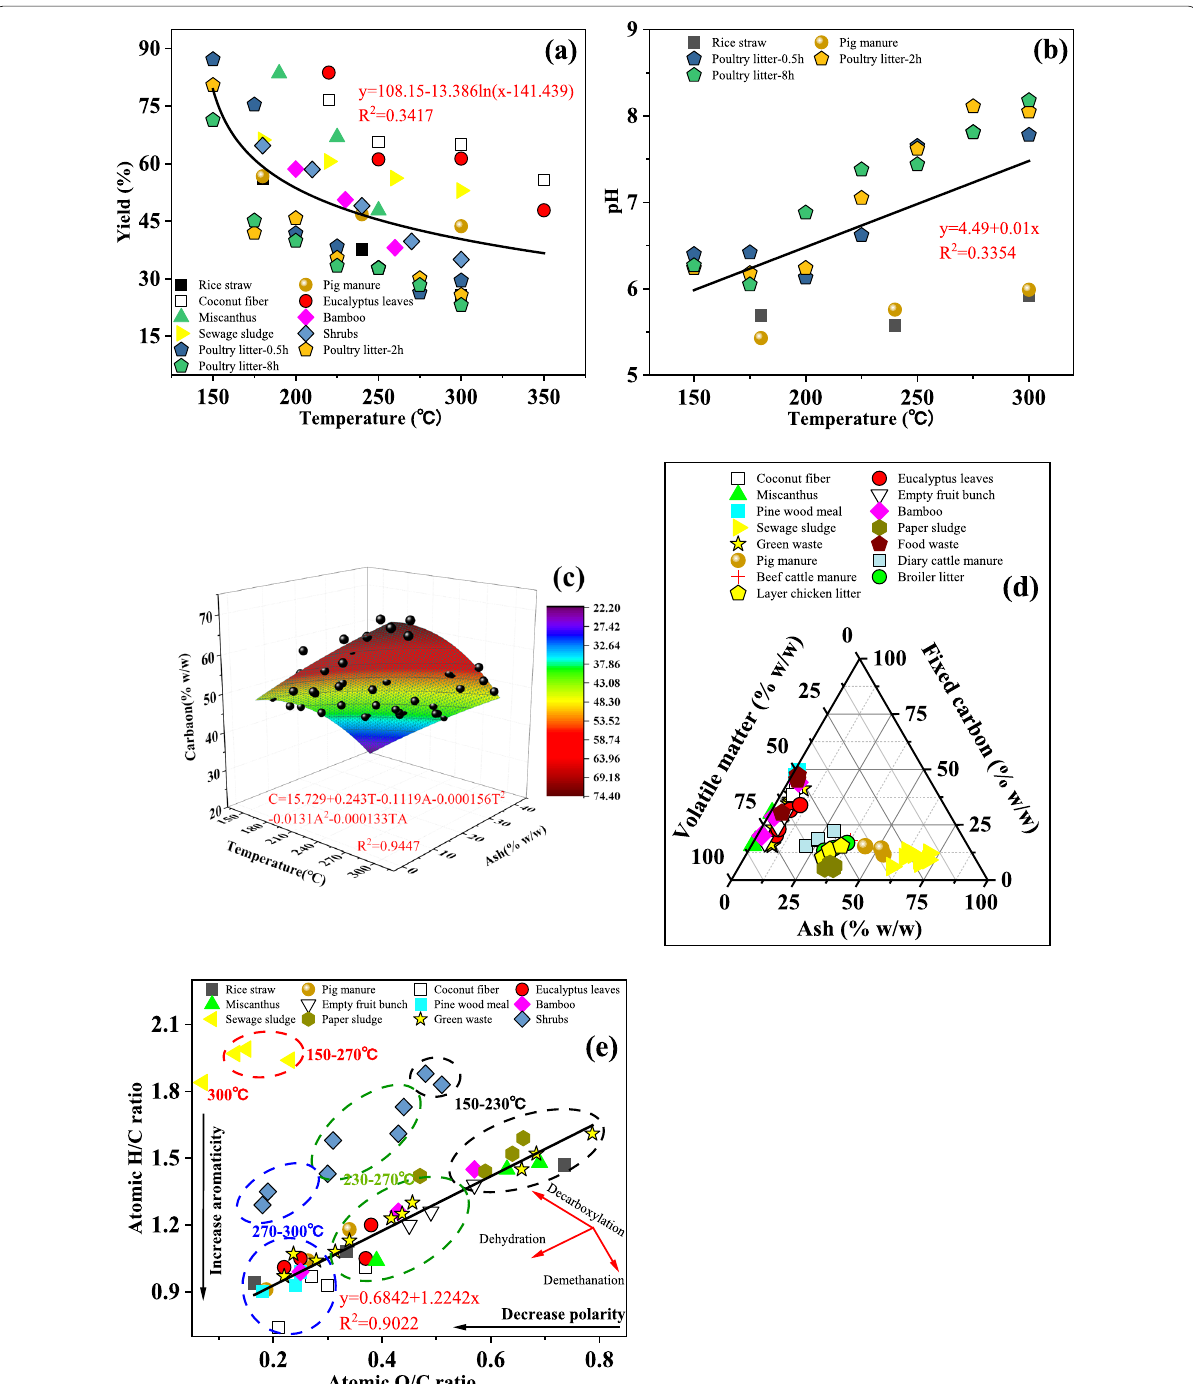
Fig. 2 Percent yields ( a ), pH ( b ), Van Krevelen diagram ( e ) of hydrochar from different feedstocks at different pyrolysis temperatures; Hydrochar total carbon content (% w/w) changes with peak pyrolysis temperature and ash content ( c ); Hydrochar ash, volatile matter, and fixed carbon proportions expressed as weight % in a ternary graph for each biochar type ( d ). [Data are from reference (Ghanim et al. 2016; Liu et al. 2017b; Raheem et al. 2022; Saqib et al. 2018; Wang et al. 2018c; Yao et al. 2016; Zhang et al. 2020b; Zhou et al. 2019; Zhu et al.